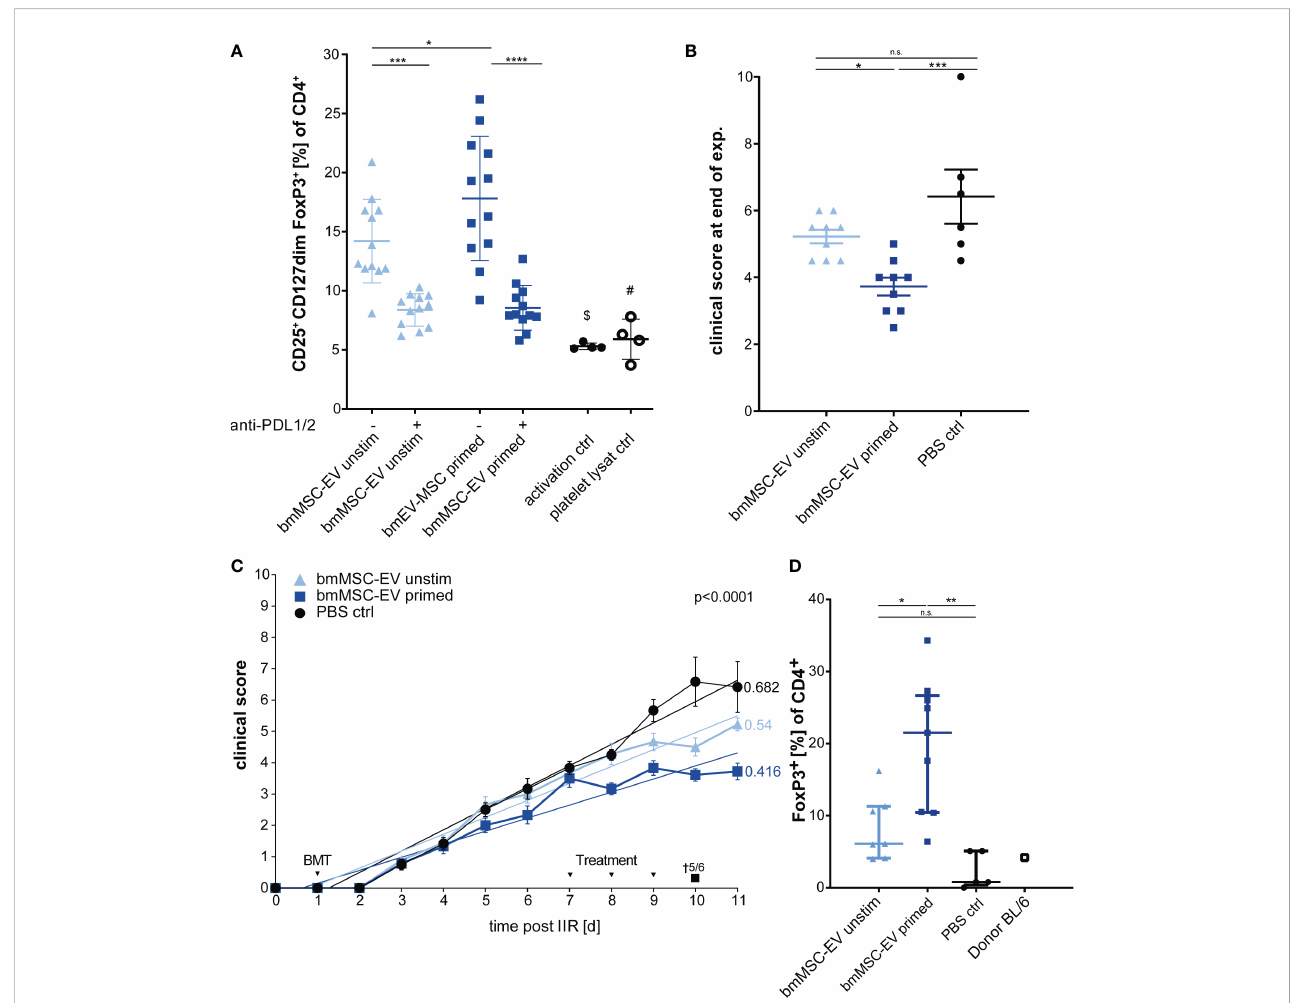
FIGURE 6 Therapeutic effects can be con fi rmed with EVs from bone marrow MSCs (bmMSCs). (A) Treg induction assay. CD3 + T cells isolated from healthy donors were incubated with EVs of unstimulated bmMSCs or TNF a , IFN g and IL-1 b primed bmMSCs. Assay was performed in the presence of inhibitory antibodies against PD-L1 (2µg/ml) and PD-L2 (2µg/ml) or isotype control (mIgG1/2a). Frequency of Tregs were determined by MFI marker expression of CD4 + CD127dim CD25 + FOXP3 + of total CD4 + by fl ow cytometry. CD3 + T cells from 4 different donors were tested with 3 different independently cultured and precipitated EV preparations of bmMSC 41.5 batch. Mixed reaction (REML) test was used to test statistical signi fi cance, ($) P= n.s., (#) P=0,0248. (B – D) Balb/c mice were lethally irradiated (day 0) and injected with CD90.2 depleted bone marrow cells and naïve CD4 cells from C57BL/6J mice to induce GvHD (day 1) and treated with bmMSC-EVs at day 7, 8 and 9. (B) Clinical score at day 11 of experiment. One-way ANOVA with Tukey ’ s multiple comparison test was used to test statistical signi fi cance. Data is shown as center value: mean; error bars: SD. (C) Time fl owchart of clinical score. Data is shown as center value: mean; error bars: SEM. Values on linear regressions indicate the slope. P value indicates statistical differences between the groups analysed by linear regression. (B, C) Combined data from two independent animal experiments; bmMSC-EVs unstimulated, n = 9; bmMSC-EV primed, n = 9; PBS control, n = 6. (D) Percentage of CD4 + FOXP3 + Tregs in whole blood after sacri fi ce. Mice with insuf fi cient blood for further processing are excluded. One-way ANOVA with Tukey ’ s multiple comparison test was used to test statistical signi fi cance. Data is shown as center value: mean; error bars: SD. bmMSC-EVs unstimulated, n = 7; bmMSC-EVs primed, n = 9; PBS control, n = 5. ns, not signi fi